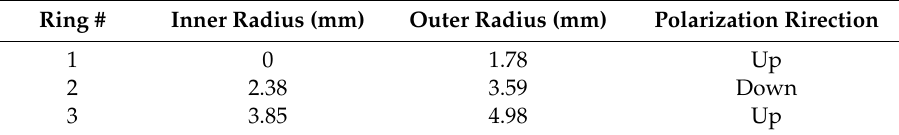
Figure 1. Image of the non-uniformly-poled piezoelectric wafer. The non-uniformly poled PZT-5A wafer is designed to enhance the third radial mode. Table 1. Polarization and dimensions of the non-uniformly poled piezoelectric wafer.